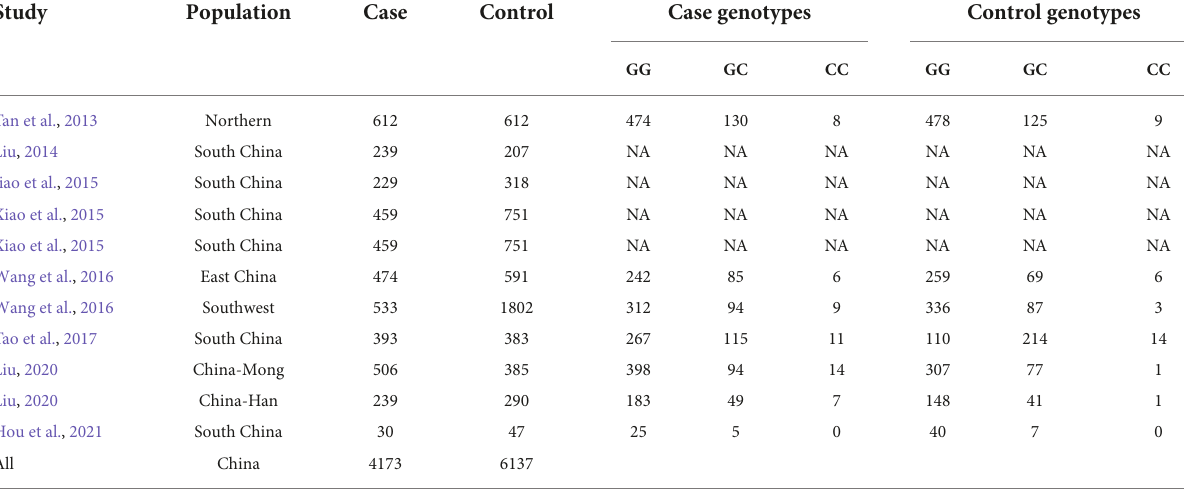
TABLE 1 Characteristics of the correlation between the rs9349407 mutation of the CD2AP gene and AD in the Chinese population. Study